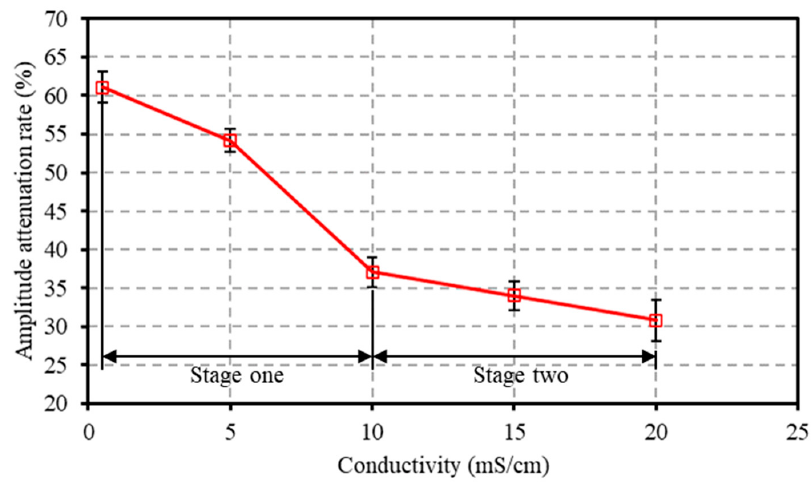
Figure 16. Amplitude attenuation rate under different conductivity.